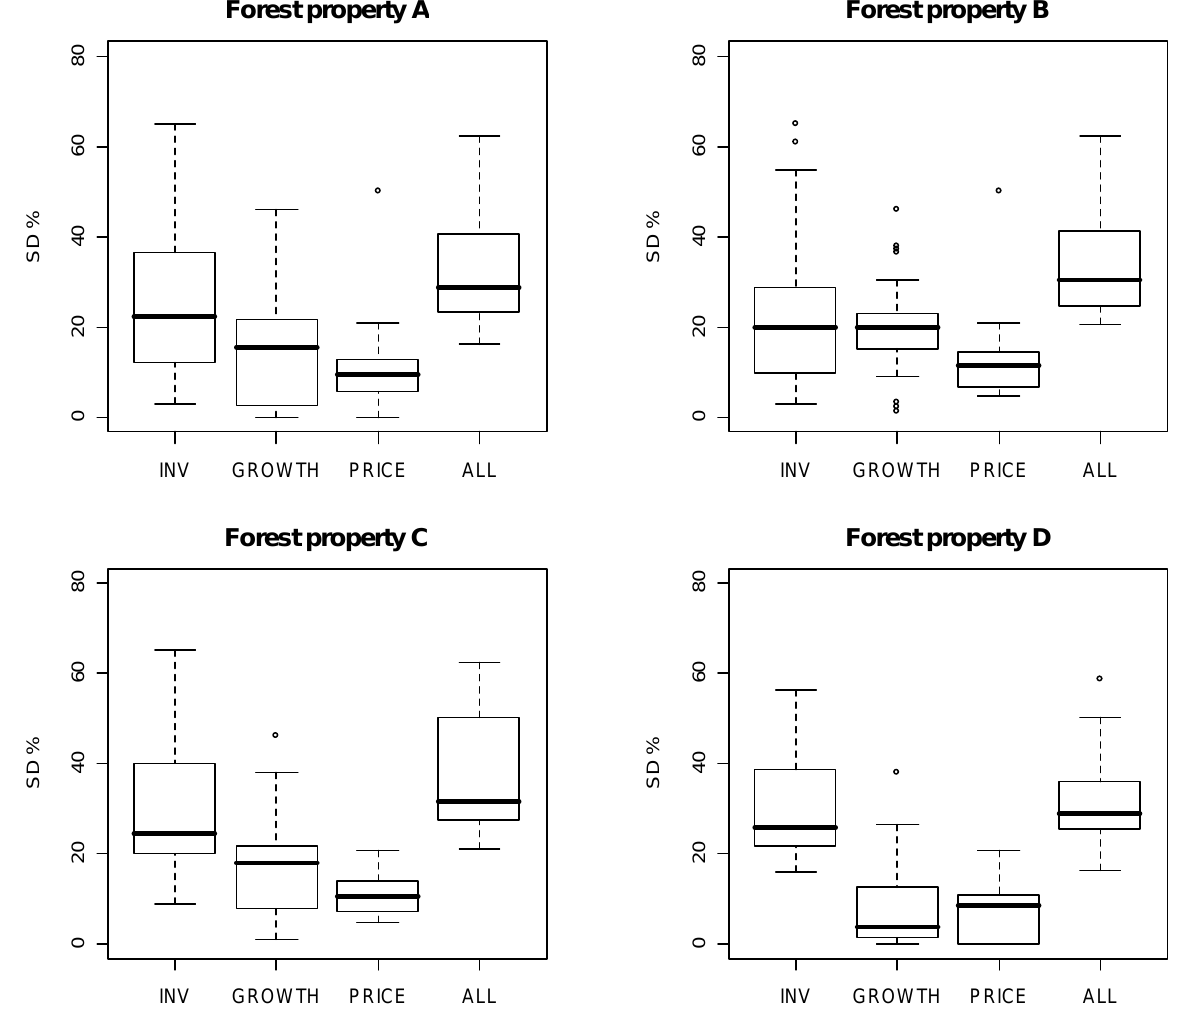
Figure 2. Variation in relative SD within stands of forest properties (25 ha, interest